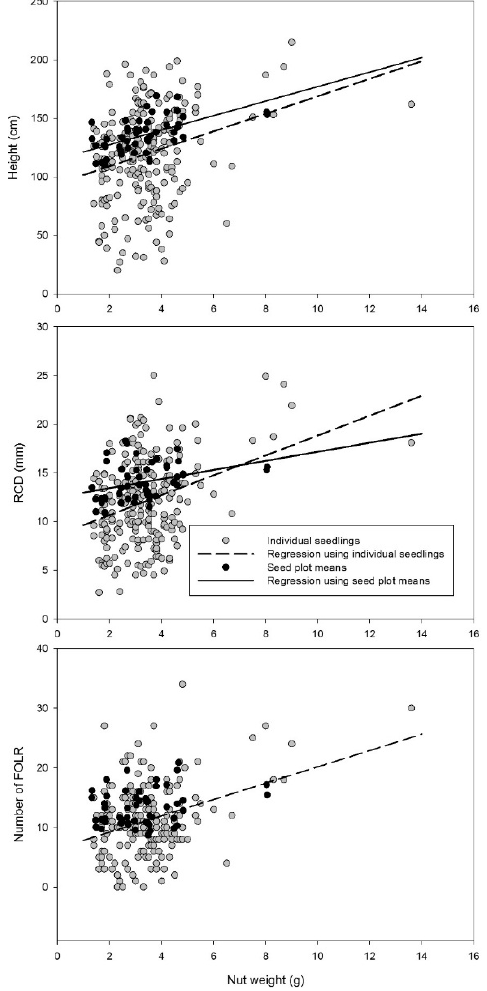
Figure 1. Scatter plots and associated linear regressions between nut weight and height, root collar diameter (RCD), and number of first-order lateral roots (FOLR) for individual seedlings and for seed plot